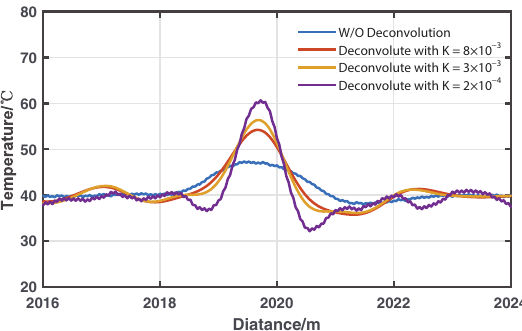
Figure 8. The resolved temperature distributions around the heated 0.5 m fiber coil under different values of parameter K .